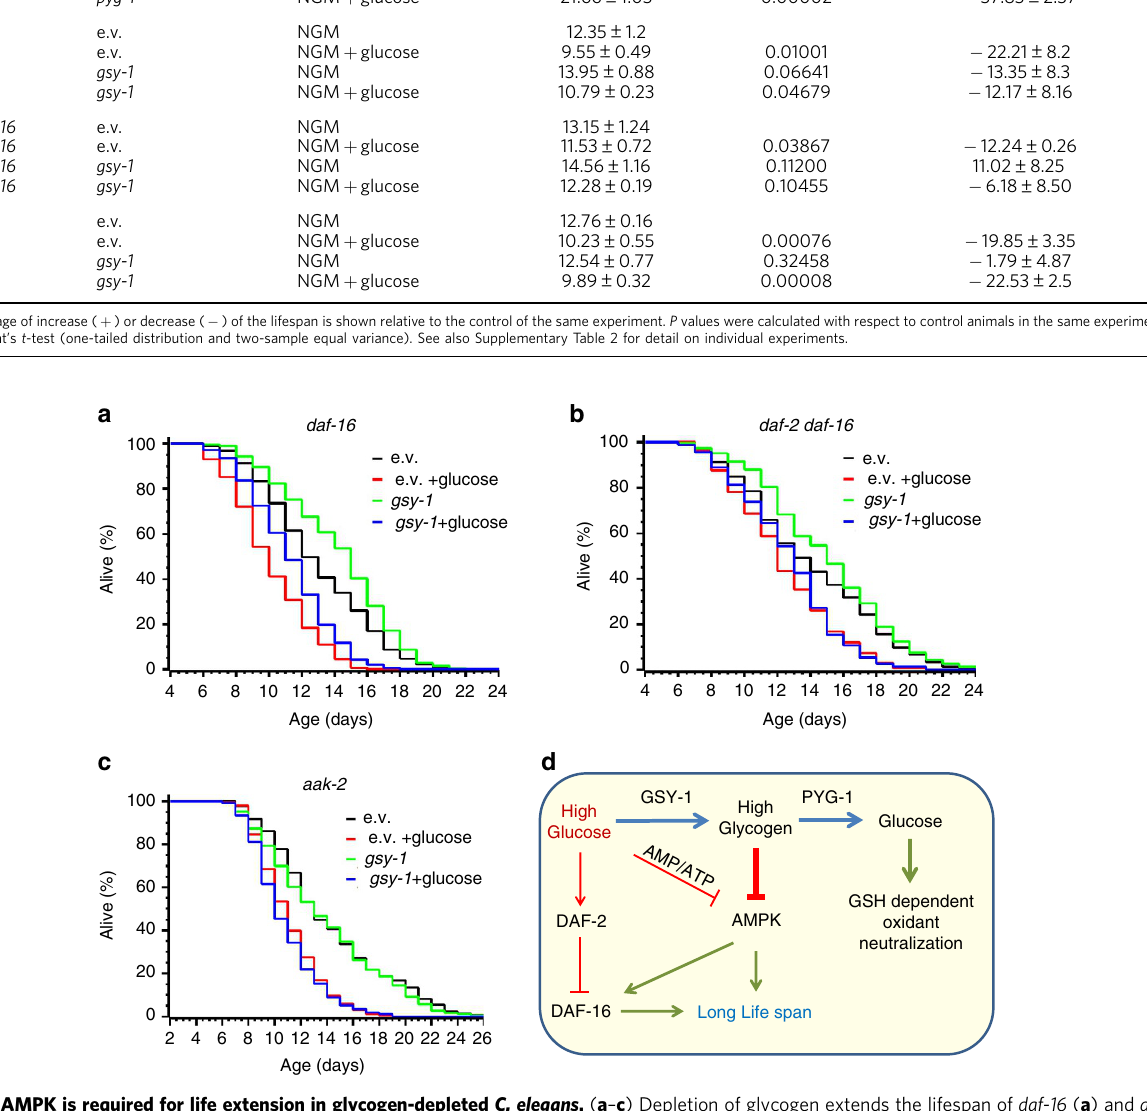
Figure 8 | AMPK is required for life extension in glycogen-depleted C. elegans . ( a – c ) Depletion of glycogen extends the lifespan of daf-16 ( a ) and daf-2 daf-16 ( b ) worms but fails to increase the longevity of aak-2 animals ( c ). Worms were fed on NGM plates seeded with E. coli HT115 harbouring either empty vector (black and red curves) or plasmids expressing gsy-1 (blue and green curves) RNAi. L4 animals were transferred to NGM plates without (black and green curves) or with (red and blue curves) glucose. The graph shows the average of three independent experiments (see also Table 2 and Supplementary Table 2). ( d ) Interplay between glycogen and insulin-like signalling controls C. elegans lifespan. A high glucose diet simultaneously activates insulin-like signalling and induces glycogen storage. IIS suppression of DAF-16-mediated transcription and inhibition of AMPK by glycogen shorten the lifespan. Pro-aging glycogen signalling overcomes the antiaging effect of IIS inhibition ( daf-2 ). Inactivation of glycogen synthesis ( gsy-1 ) prevents glycogen accumulation, relieves AMPK and extends the lifespan in wt, daf-16 and daf-2 worms on a high glucose diet. Oxidants force the glucose flow through PPP to regenerate cellular GSH, thus depleting glycogen stores and extending the